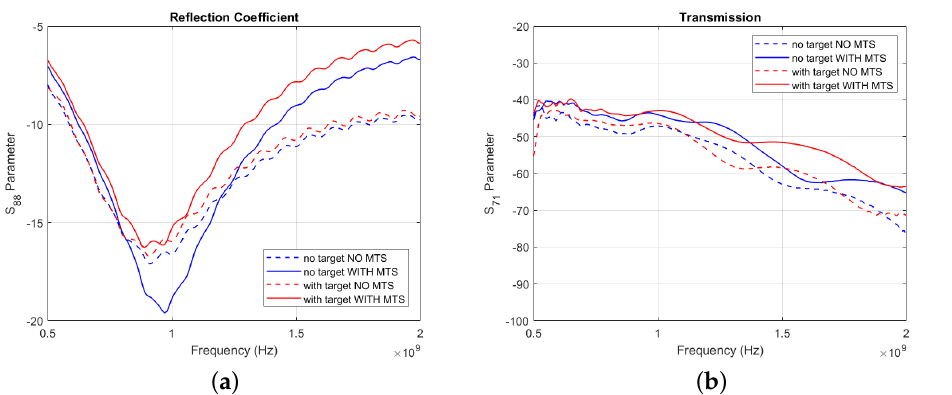
Figure 7. ( a ) Measured S 88 Parameter for the triangular patch antenna array in the “with target” (red lines) and “no target” (blue lines) configuration, with (solid lines) and without MTS (dashed lines) ( b ) Measured S 71 Parameter for the triangular patch antenna array in the “with target” (red lines) and “no target” (blue lines) configuration, with (solid lines) and without MTS (dashed